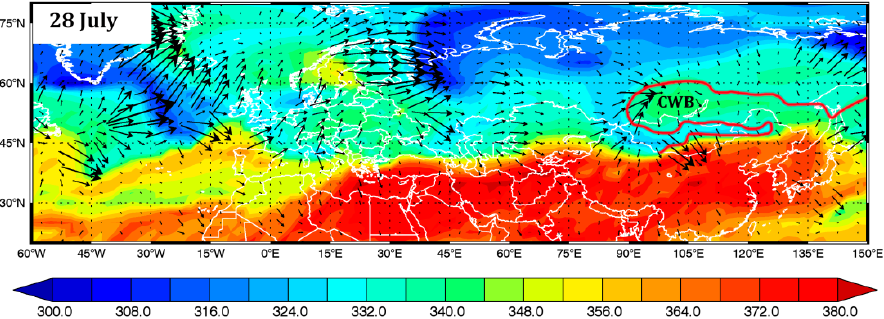
Figure 12. Circulation pattern (WAF and PV- Θ) on 28 July (5th period).